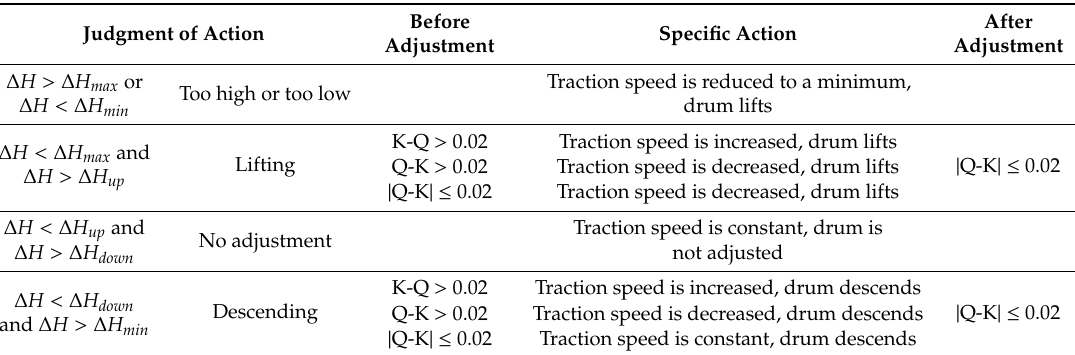
Table 1. Strategy of action